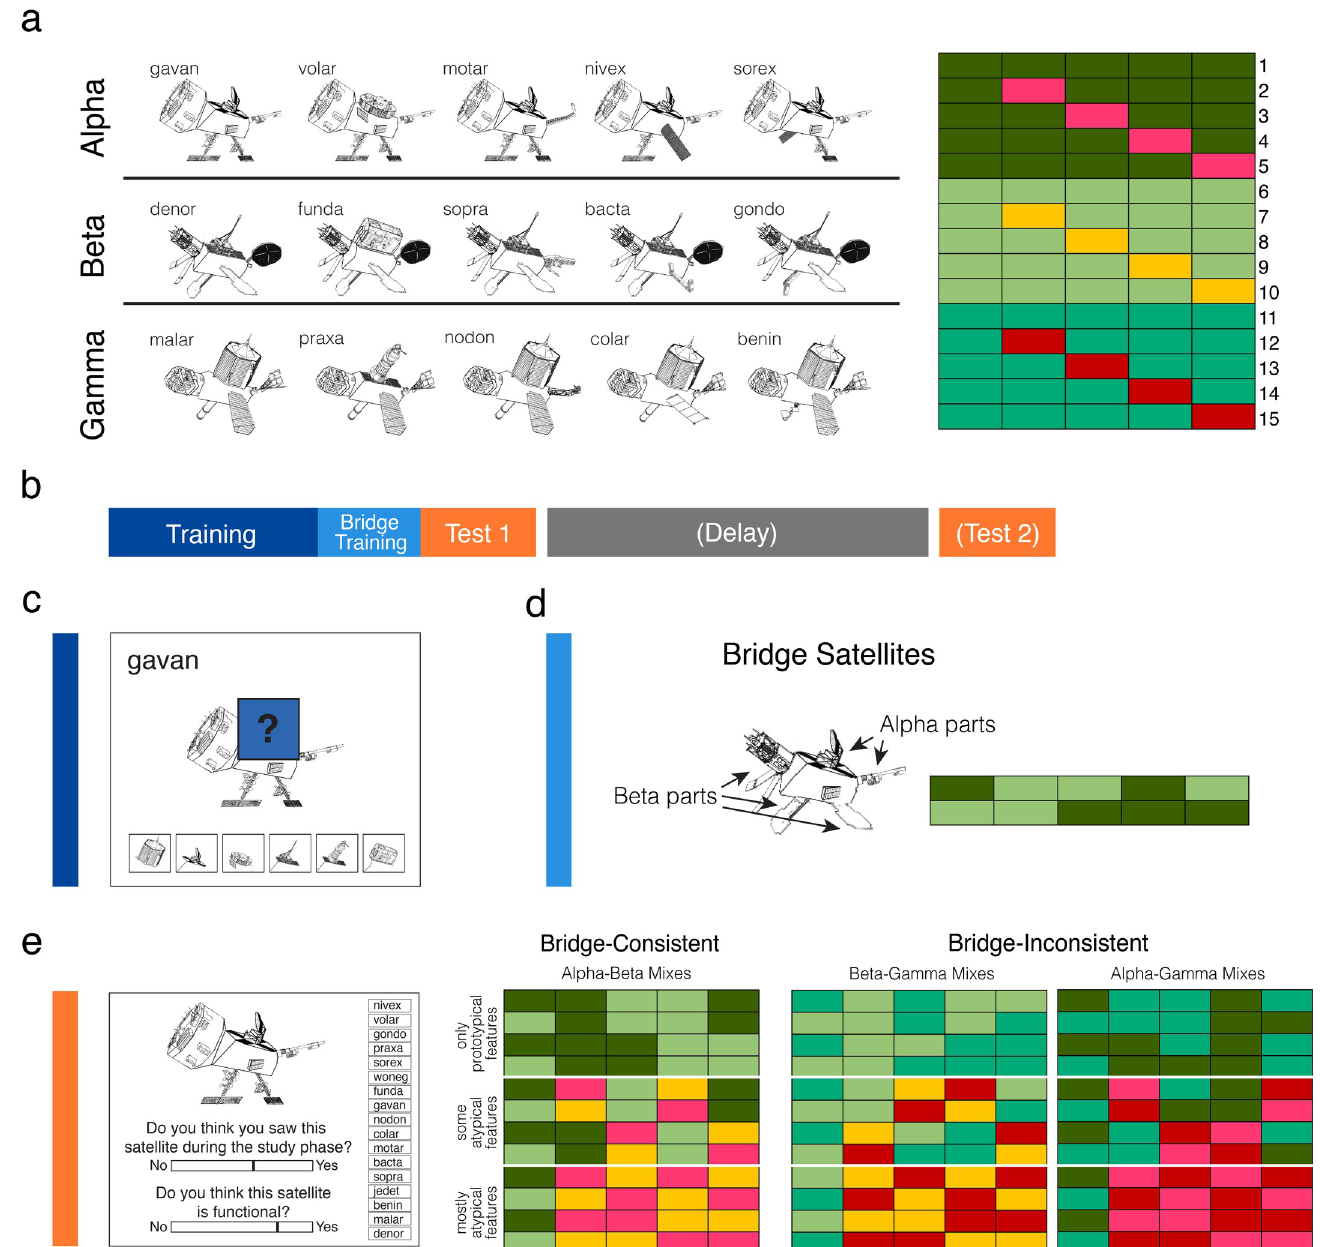
Fig 1. Stimuli and task design. (a) Examples of the 15 training exemplars that made up the three categories (left). Category structure of the 15 training exemplars (right) depicting the features (columns) that made up each exemplar (rows). Rows 1–5 are Alpha exemplars, 6–10 Beta, and 11–15 Gamma. Shades of green depict category prototypical features and non-green colors indicate category atypical features. (b) General structure of experiments. (c) Example of a training trial, where participants inferred missing features. (d) Example of a bridge satellite combining prototypical Alpha and Beta features and the feature structure of the two bridge satellites shown during bridge training. Participants learned these satellites in the same way as in the training phase. (e) Schematic of test trial (left) which involves making slider judgments about whether that particular satellite was seen during training (recognition) and if the satellite was functional (functional judgment). Participants might then guess the exemplar code name by clicking on the name (code name memory). Feature structure is depicted (right) for the test items which combined features of the initially learned categories. These satellites could combine features from the same two categories shown during bridge training (bridge- consistent) or from other two pairings of categories (bridge-inconsistent). Test items also could vary in the typicality of their features (only prototypical, some atypical, mostly atypical).